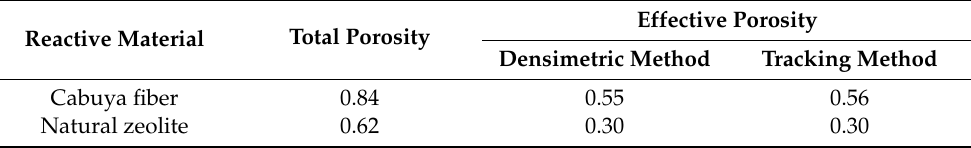
Table 2. Total and effective porosity values of the reactive materials